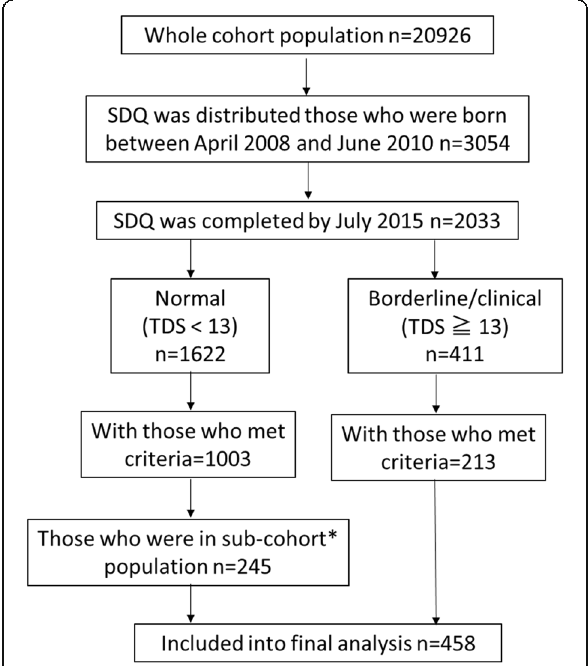
Fig. 1 Selection of study population. *The sub-cohort of 4869 participants, which corresponded to 23.3% of all participants ( n =20,926) in the Hokkaido study were established. In this sub-cohort, 500 participants who were randomly selected from each enrollment year between 2003 and 2011, and all 369 participants from the enrollment year 2012 were included. The sub-cohort population was supposed to be representing original cohort population. The aim of establishing the sub-cohort population was for effective exposure